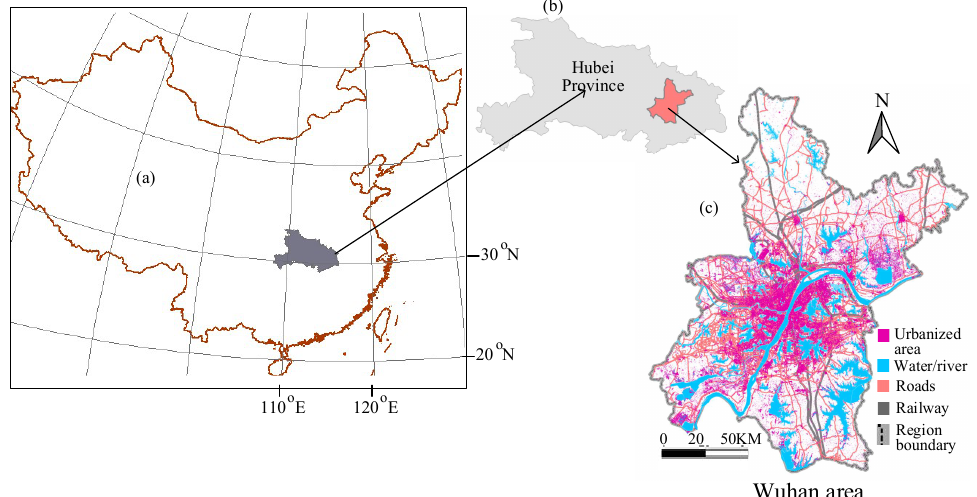
Figure 1. The study area, Wuhan metropolis; ( a ) the location of the province, ( b ) boundary of the province, ( c ) Wuhan metropolis area. Table 1. Datasets used in the study. NDBI , normalized di ff erence built-up index; DEM, digital elevation model; PLAND, percentage of landscape; AI, aggregation